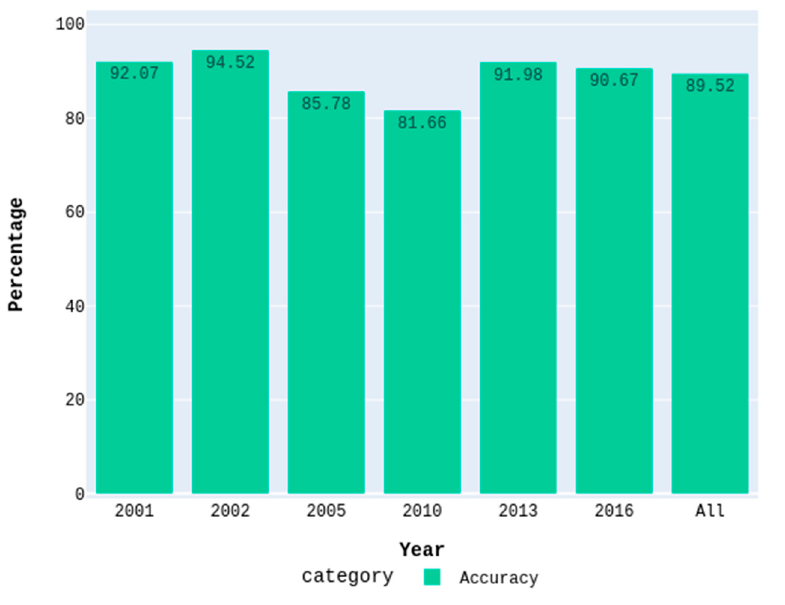
Figure 12. Plot of accuracy metrics of series fire maps.